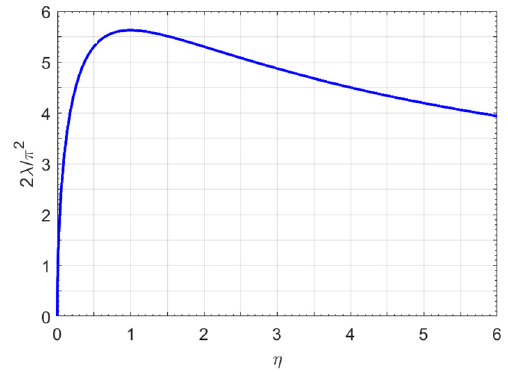
2 λ 2 λ with changing η with changing η . Figure 7. The variation of π 4 π 4 2 λ with changing η . π 4